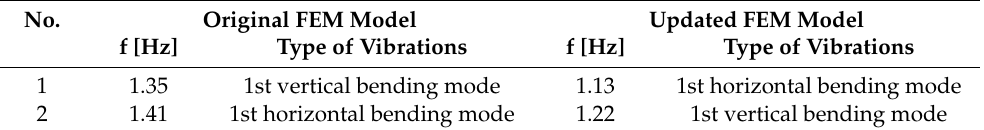
Table 3. Comparison of calculation results.